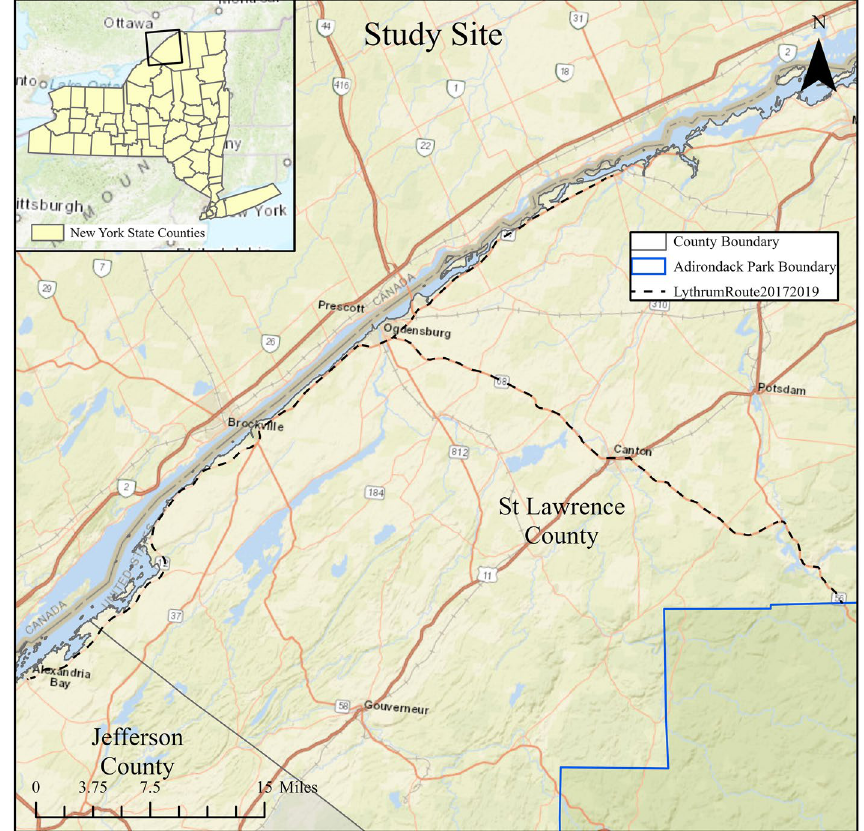
Figure 4. Map of the study site, created in ArcGIS Pro v2.9 50 . The study route followed State Route 56 from the Adirondack Park boundary, to State Route 68 in Colton to Ogdensburg, north along State Route 37 to Waddington, and south along State Route 37 to State Route 12 to Alexandria